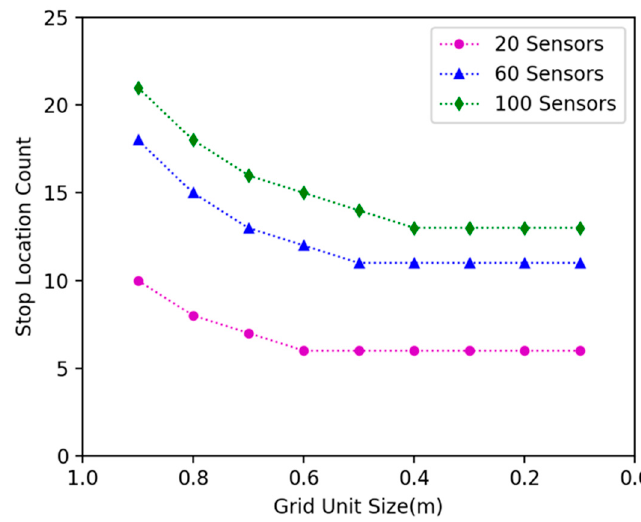
ff ect of di ff erent grid sizes on the number of specified docking spots. Figure 11. The effect of different grid sizes on the number of specified docking spots. Figure 11. The e